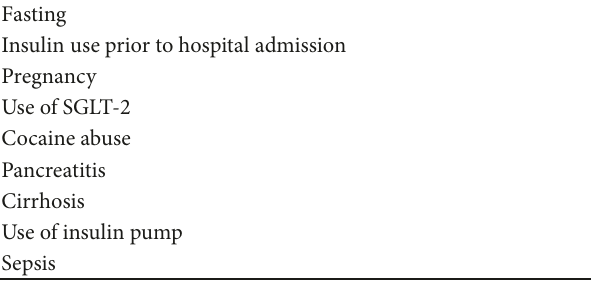
Table 2: Causes of euglycemic diabetic ketoacidosis.